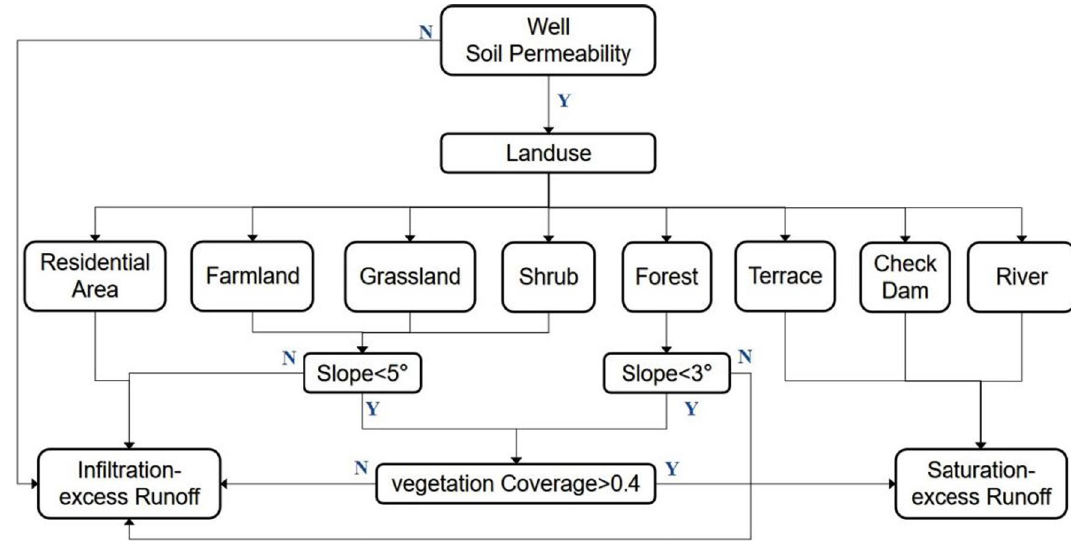
Fig. 3 Division flowchart of dominant runoff